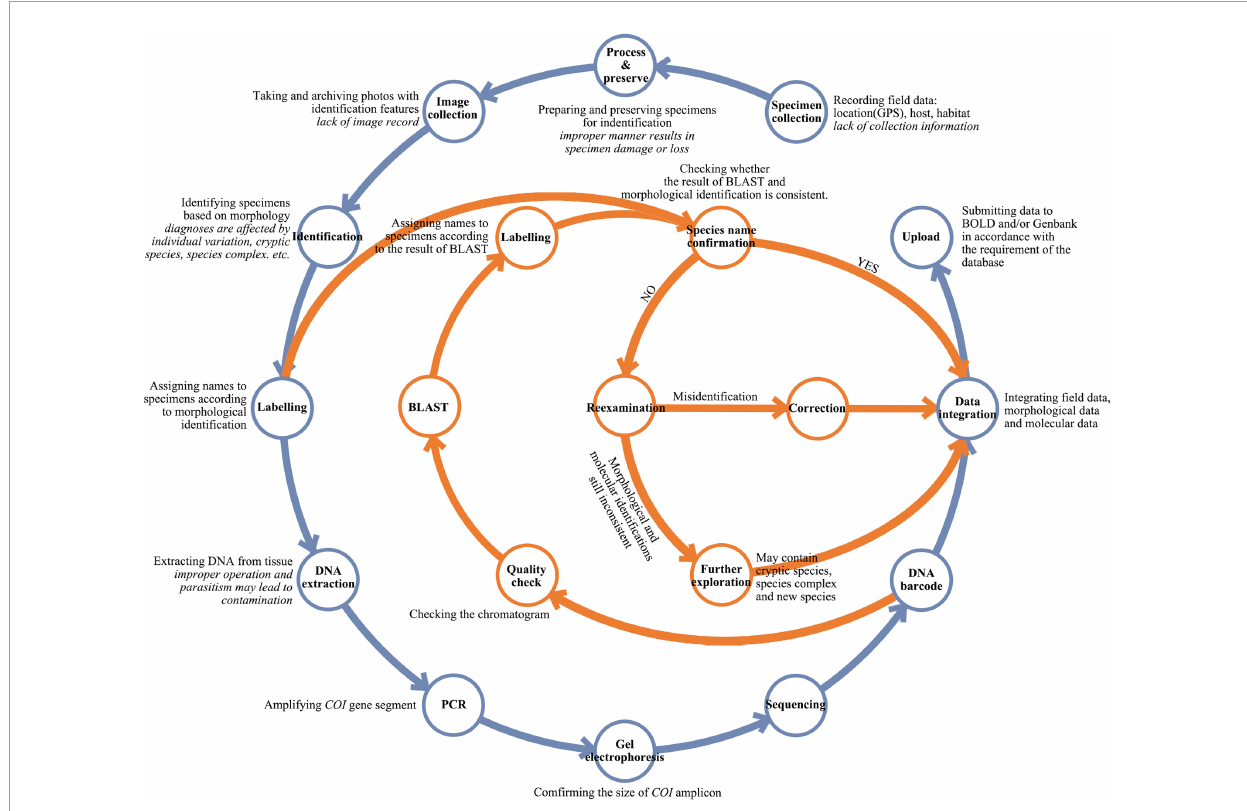
FIGURE2 A flow chart for DNA barcoding workflow. Simplified workflow commonly used for DNA barcoding is shown in blue and quality check practices recommended herein are shown in orange. The key steps of the workflow are in bold with explanations in regular font, and possible errors or deficiencies in